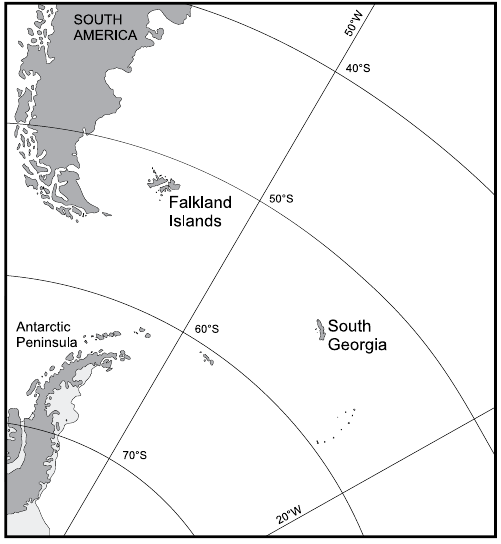
Fig. 1. Location of South Georgia and the Falkland Islands in the South Atlantic Ocean. Modi- fied from Headland